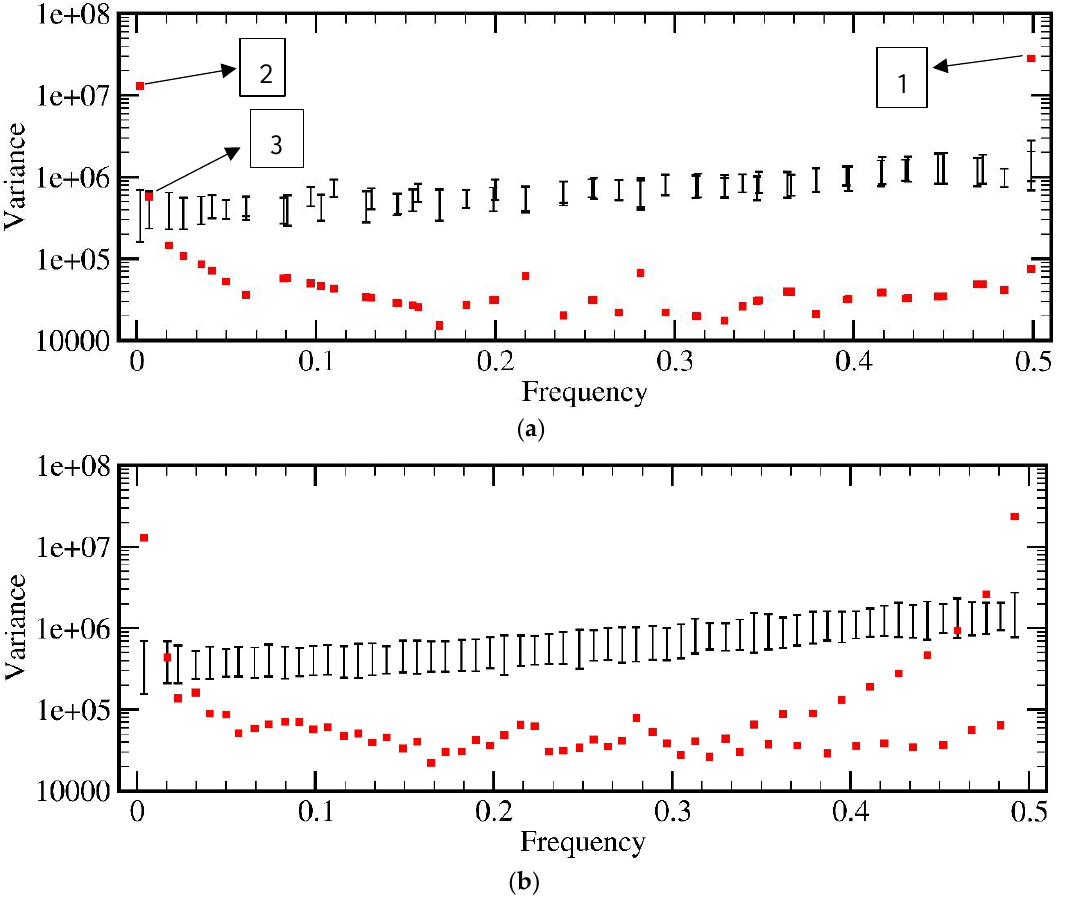
Figure 9. Monte Carlo SSA based on data ( a ) and null hypothesis empirical orthogonal functions (EOFs) test ( b ).